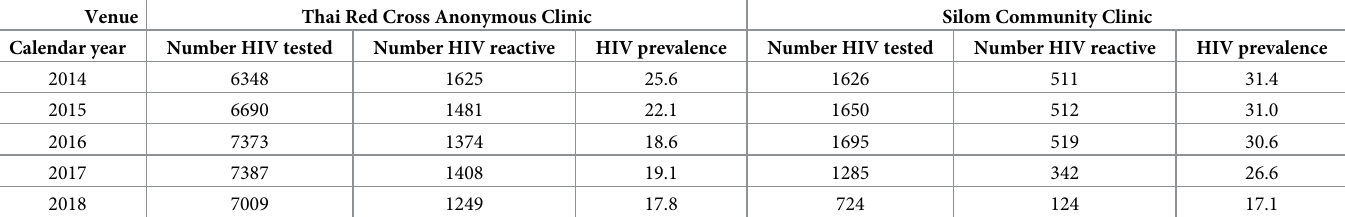
Table 1. HIV prevalence among men who have sex with men attending HIV testing and counseling services at the Thai Red Cross Anonymous Clinic and Silom Community Clinic Bangkok, 2014–2018. Venue